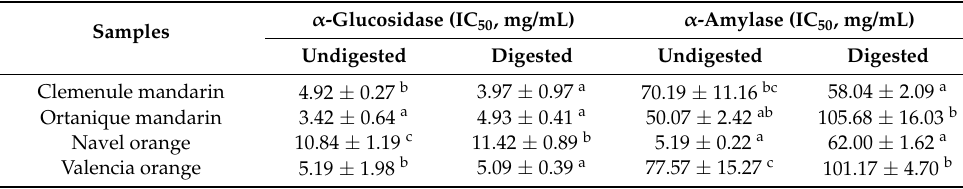
Table 2. Inhibitors of the enzymes α -glucosidase and α -amylase from raw citrus pomaces and bioaccessible